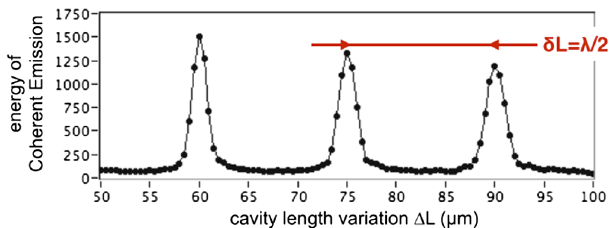
FIG. 9. Analytical calculation of coherent emission: integration over the frequency ν of the square of modulus of length